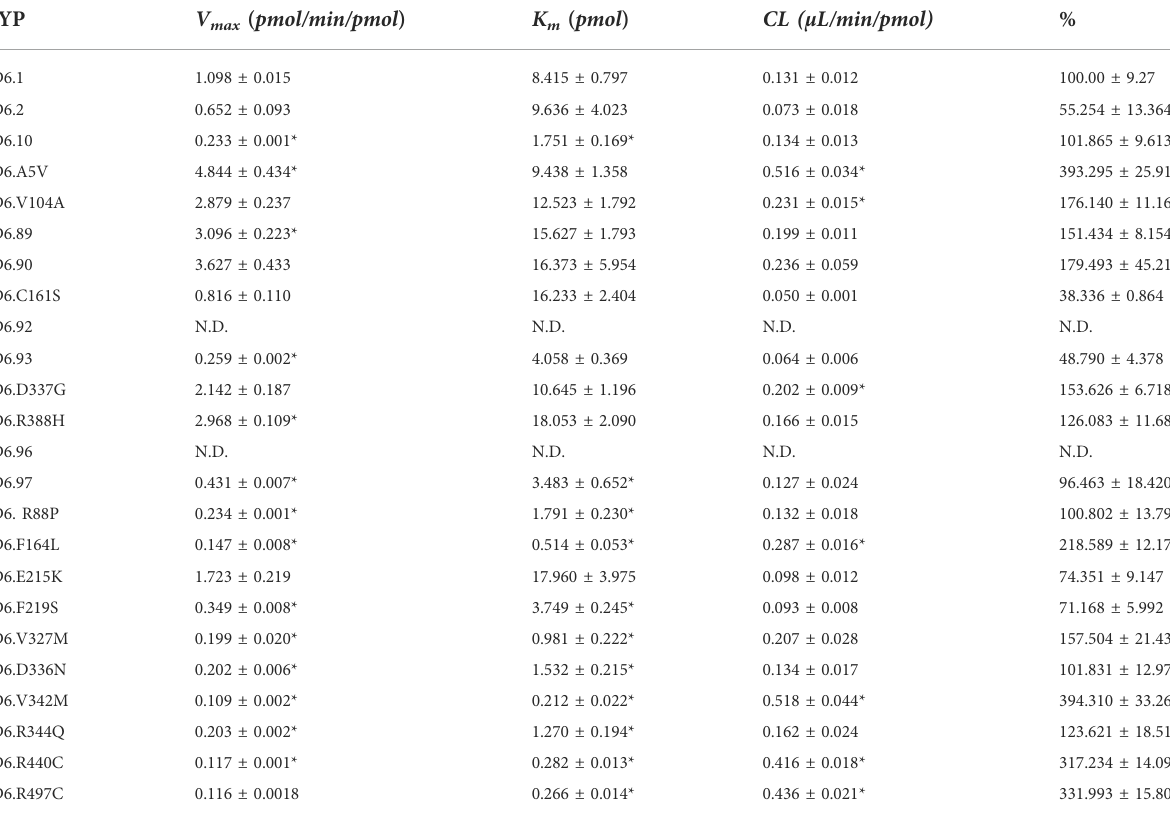
TABLE 1 Kinetic parameters of fl uvoxamine catalyzing in CYP2D6.